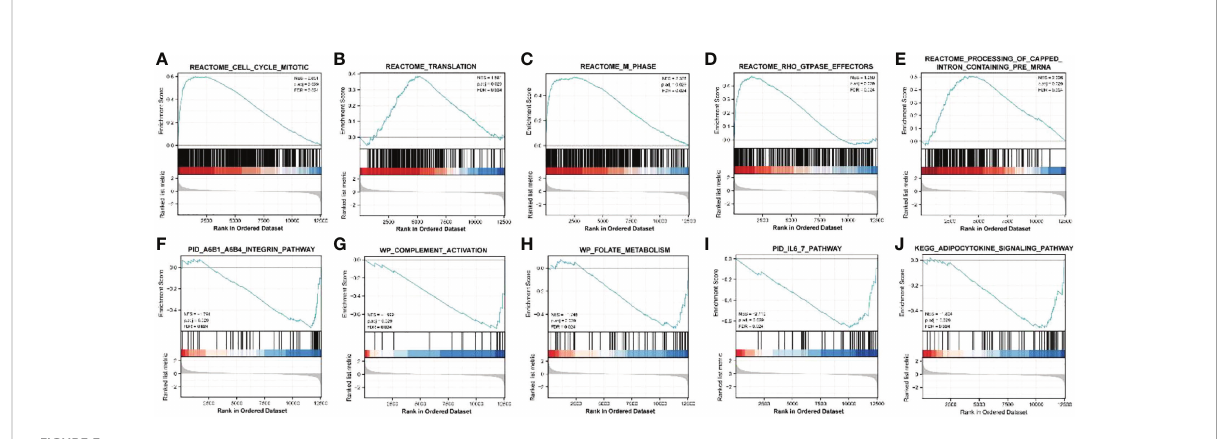
immune cells. Figure 5B shows the proportions of the different immune cells in all samples; natural killer (NK) cells showed the highest proportion. Figure 5C shows the proportions of the different immune cells in a single sample. Correlation analysis between diagnostic markers and immune cells. Correlation